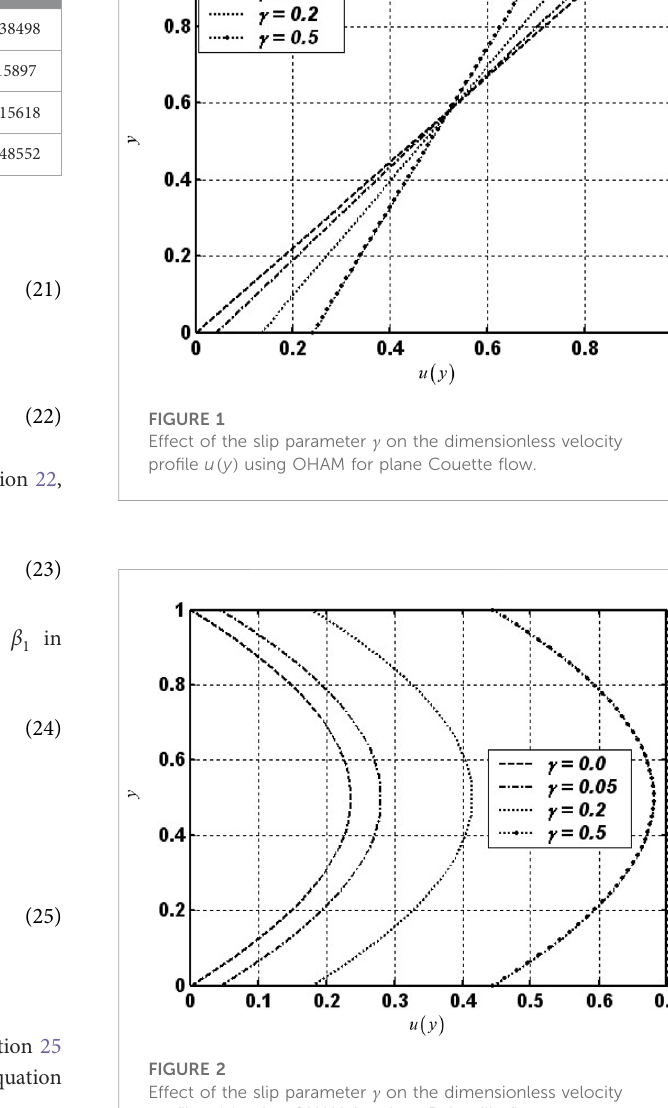
Effect of the slip parameter γ on the dimensionless velocity pro fi le u ( y ) using OHAM for plane Poiseuille fl